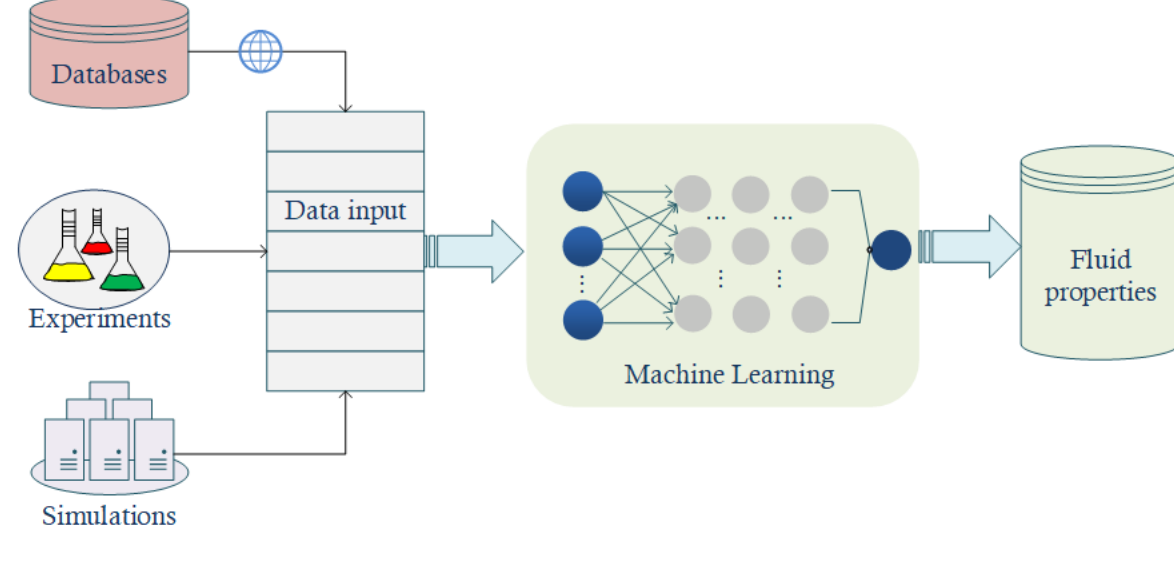
Figure 2. Fluid properties extraction flowchart.